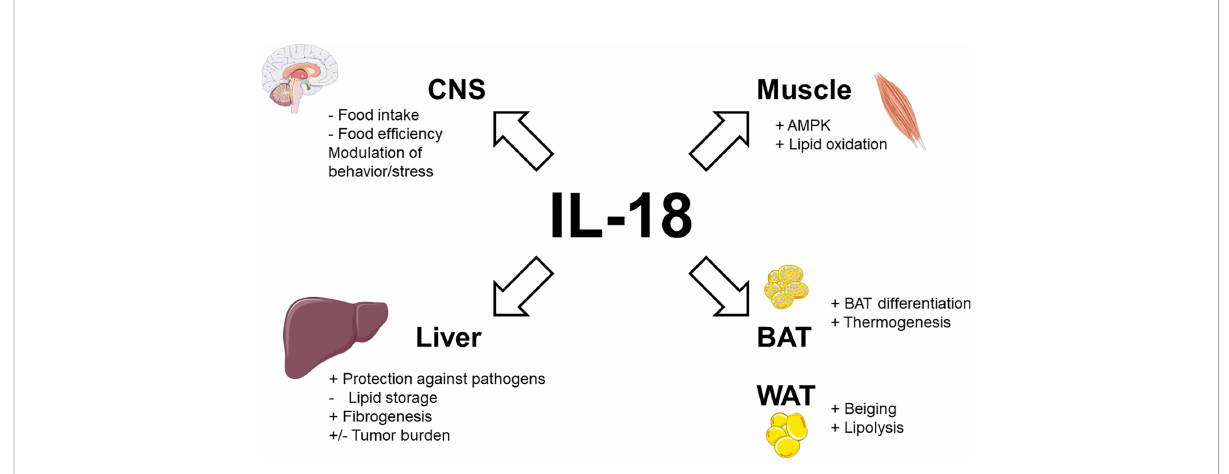
FIGURE 1 Physiological actions of IL-18 signaling in metabolic tissues. Stimulatory effects are indicated by plus signs (+), inhibitory effects by minus signs ( − ). Figure produced using illustrations from Servier Medical Art (smart.servier.com) under Creative Commons Attribution 3.0 unported